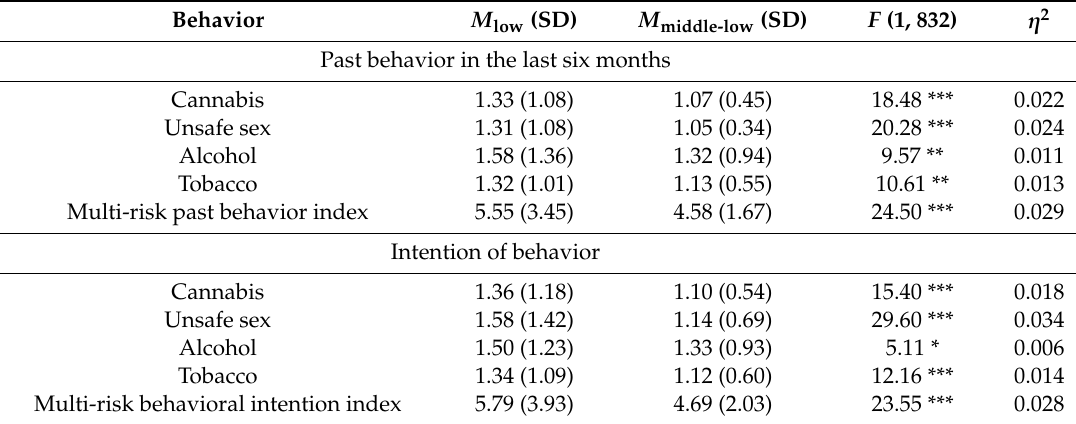
Table 3. Frequency and Intention of Risk Behaviors for Low and Middle-low Status